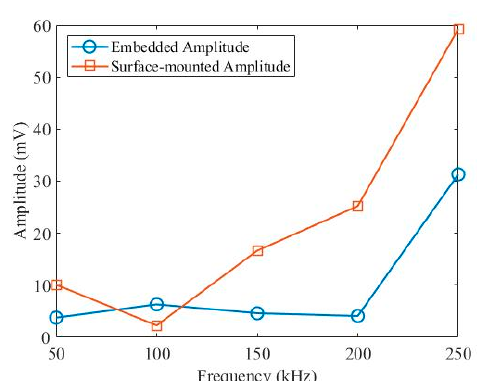
Comparisons of first peak amplitudes between embedded and surface-mounted PZT transducers.